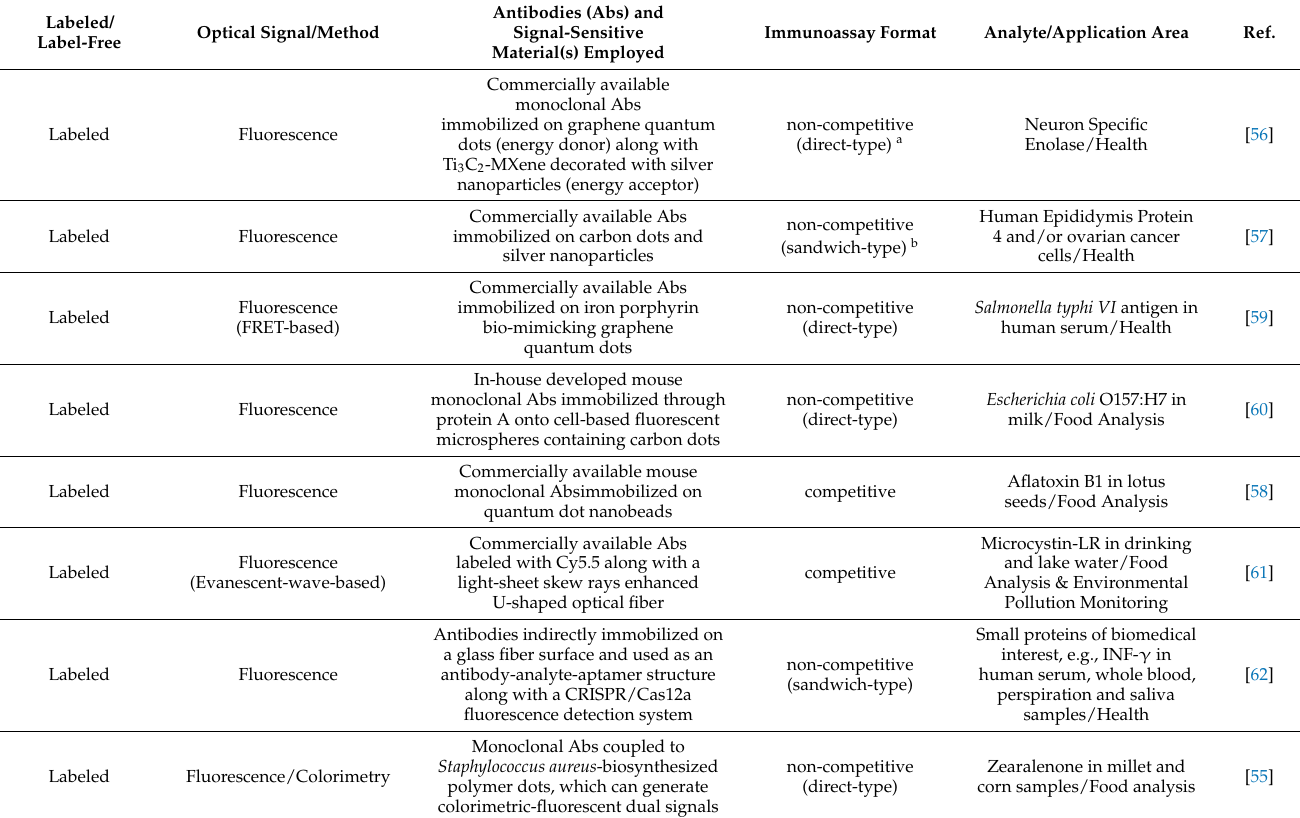
Table 1. Reports on optical immunosensors published in